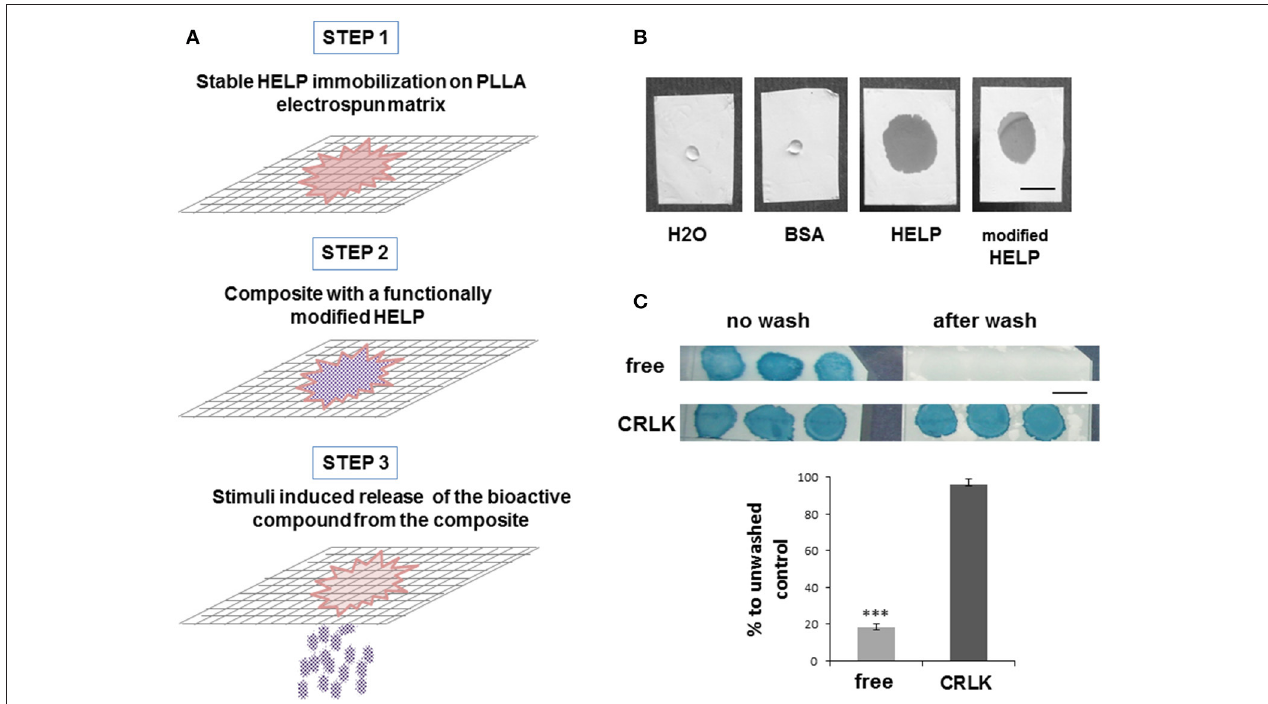
FIGURE 1 | HELP-PLLA composite design. (A) Schematic description of the experimental approach; (B) Representative images of different protein aqueous solutions 0.5min after deposition on PLLA matrix. Bar is 5mm; (C) Stabilization effect of the HELP cross-linking process (CRLK) compared to simple deposition of the protein (free) on PLLA matrix: representative images of unwashed and washed samples, Amidoblack staining. Bar is 5mm. Evaluation of sample stability after washing is reported in the histogram. Each value represented the mean ± SD, n = 3. Differences between free and cross-linked samples after extensive washing were assessed by one-way ANOVA, *** p < 0.001 compared to unwashed